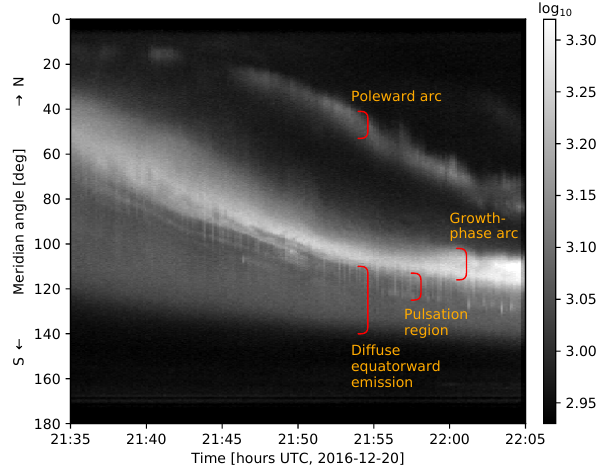
Figure 6. High-time-resolution optical keogram, showing pulsating aurora centred meridionally at the location of